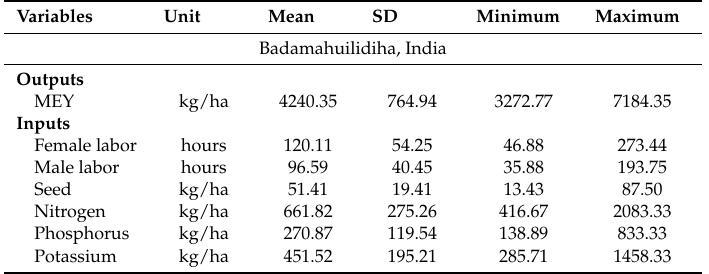
Table 2. Descriptive statistics for the CA cropping system of reduced tillage, improved maize intercropped with cowpea for smallholder farms in tribal villages in Odisha,